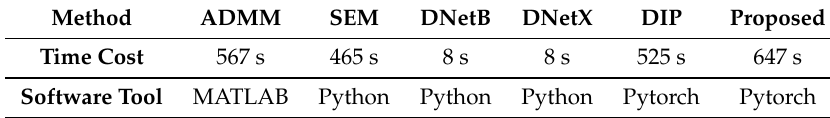
Figure 9. Comparison of the convergence between the DIP and the proposed variational DIP. Table 5. Showing the computational time costs of the different joint demosaicing and denoising